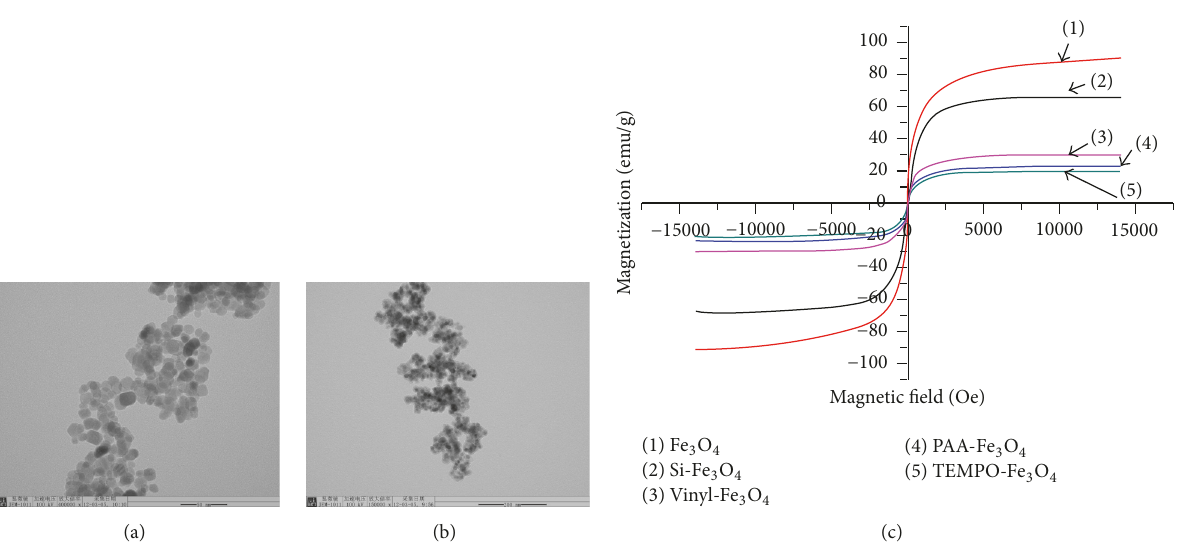
Figure 2: TEM images of bare Fe 3 O 4 materials (a); TEMPO-MNPs material (b); magnetization curves of the resulting Fe 3 O 4 materials (c).